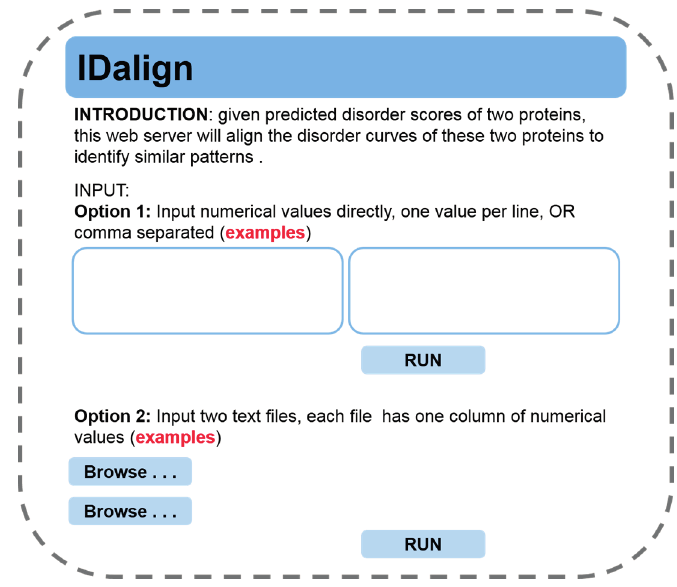
Figure 9. Layout the IDalign web